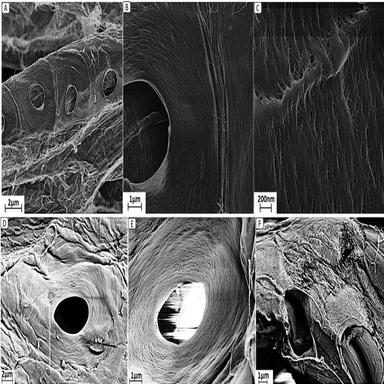
Various comparative HIM (aec) and SEM (def) micrographs on spruce never dried, critical point dried pulp: a) pits at low magnification, b,c) pit at high magnification, d) pit at low magnification, e,f) pit at higher magnification with nanofibrils shown.